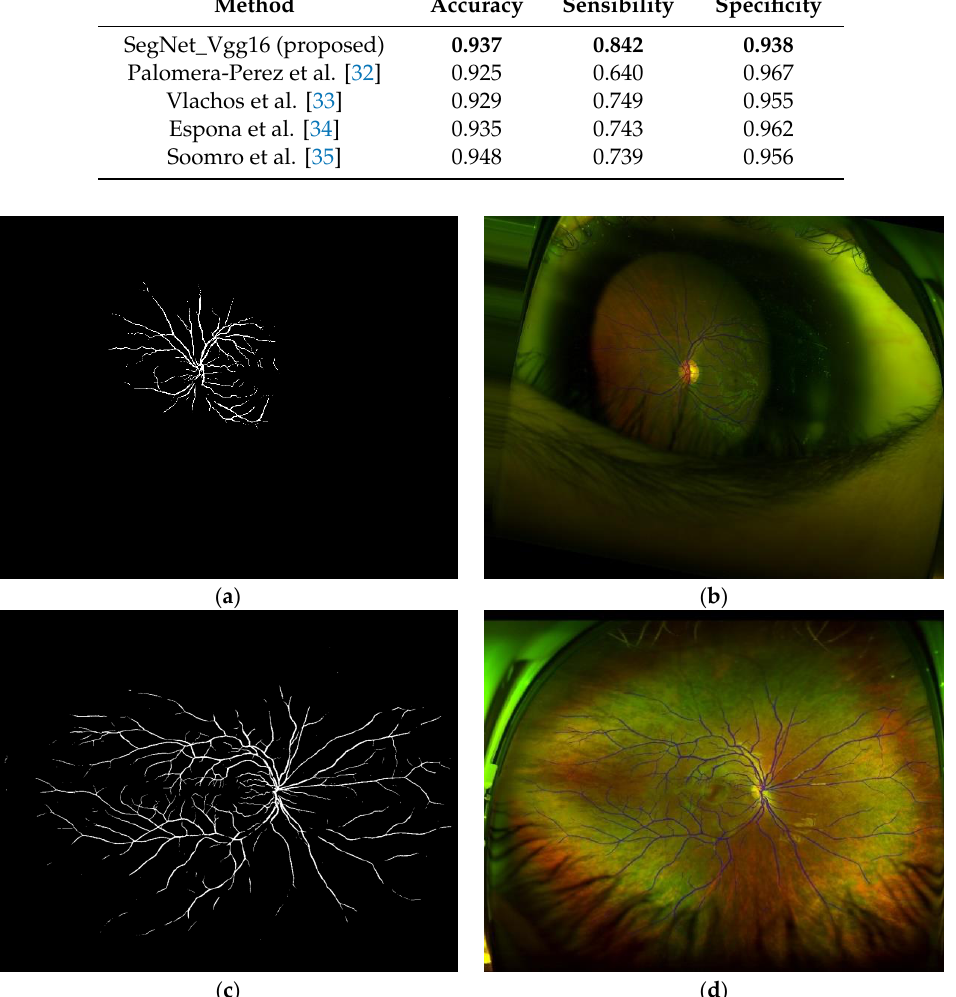
Figure 14. ( a ) and ( c ) results of vessel segmentation. ( b ) and ( d ) the segmented vessel superimposed on the original